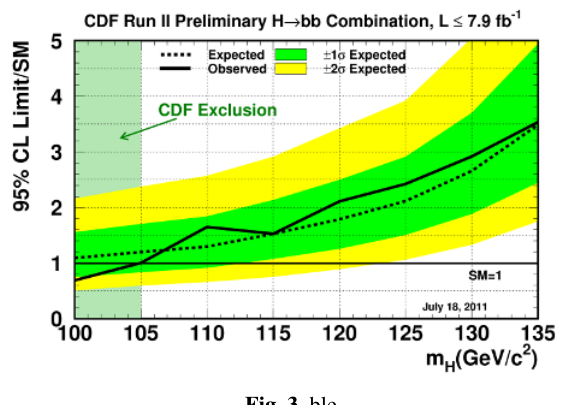
Fig. 3. ble Fig. 4. Observed and expected 95% C.L. measured by the CDF experiment using a luminosity up to 7 . 8 fb − 1 for di ff erent SM Higgs boson masses and with a final state H → b ¯ b . The limit is obtained combining all the CDF primary search channels as they share the H → b ¯ b signature.